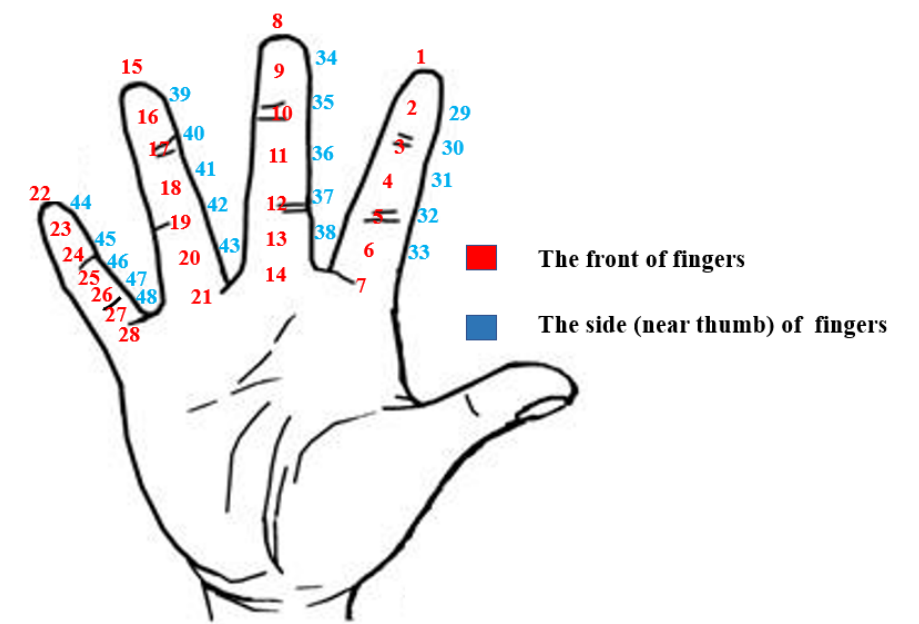
Figure 6. The serial number of different areas of the fingers.